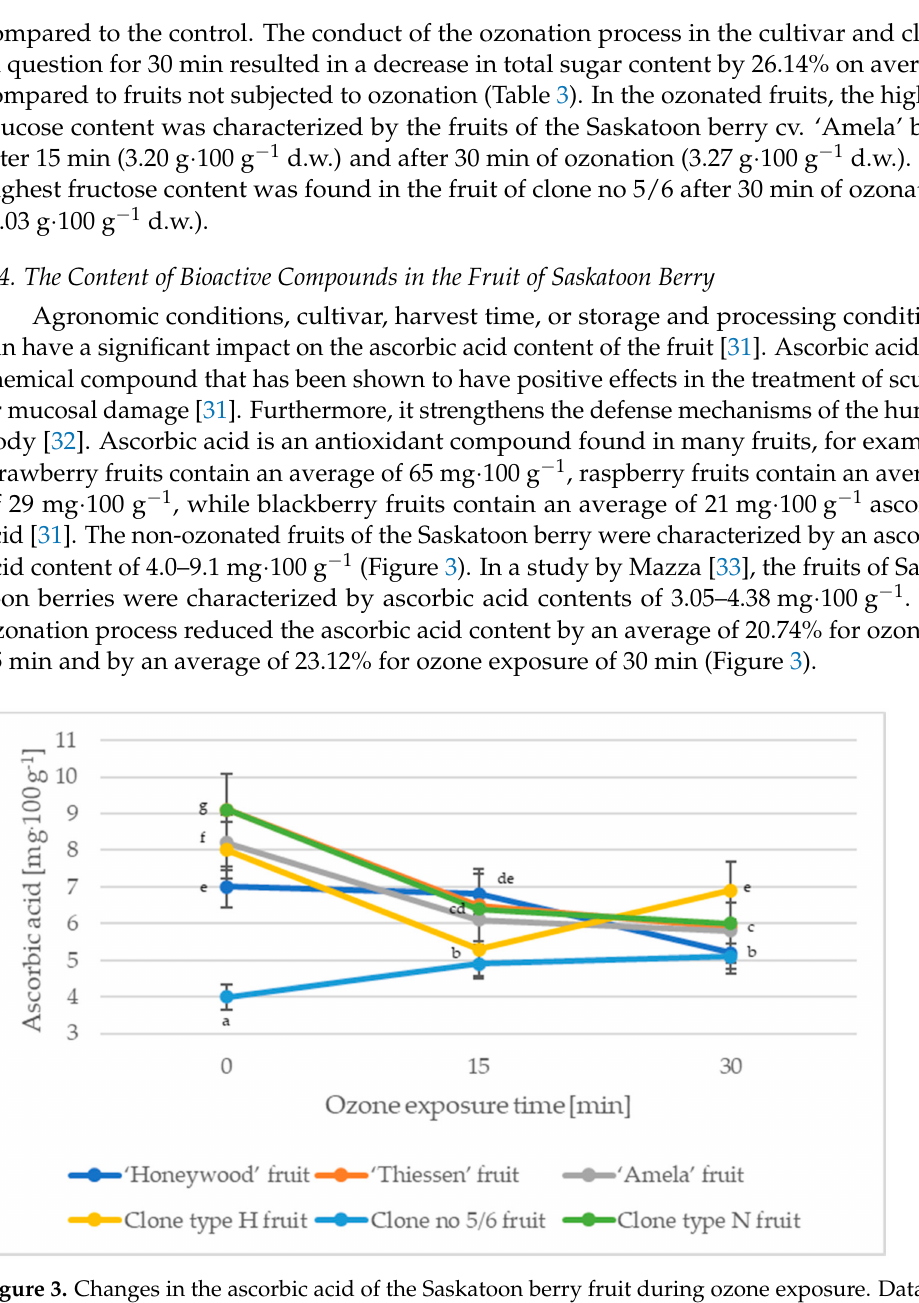
Figure 3. Changes in the ascorbic acid of the Saskatoon berry fruit during ozone exposure. Data are expressed as mean values (n = 3) ± SD; SD—standard deviation. Mean values with different letters are significantly different ( p <